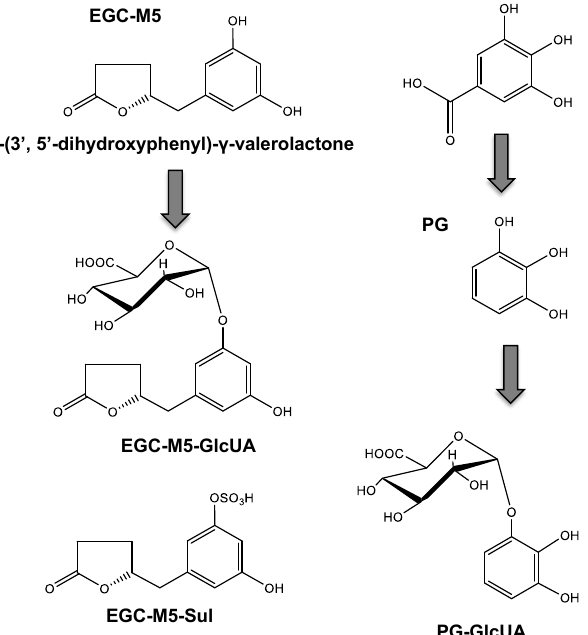
Figure 2. The structure of EGCG metabolites.